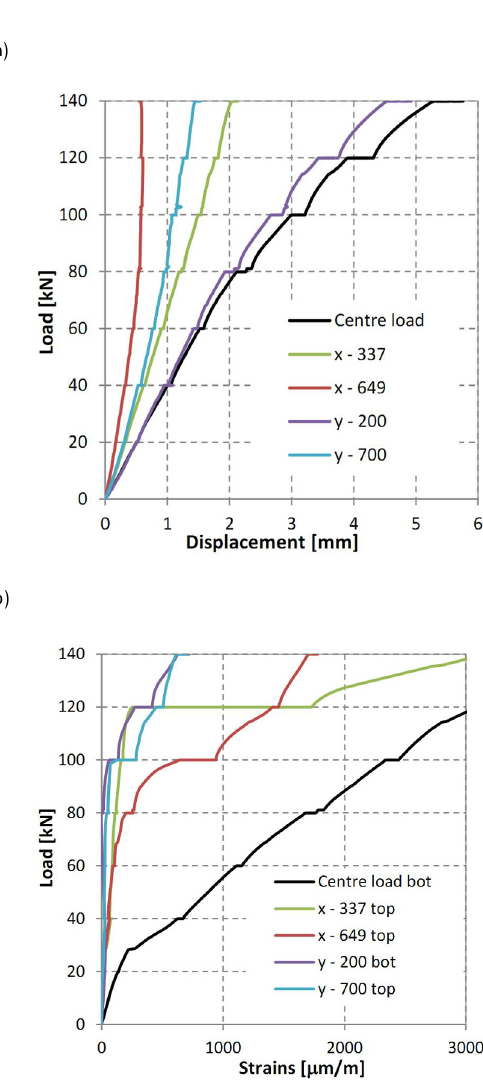
Figure 11. Edge load, (a) Displacements, (b) Strains.